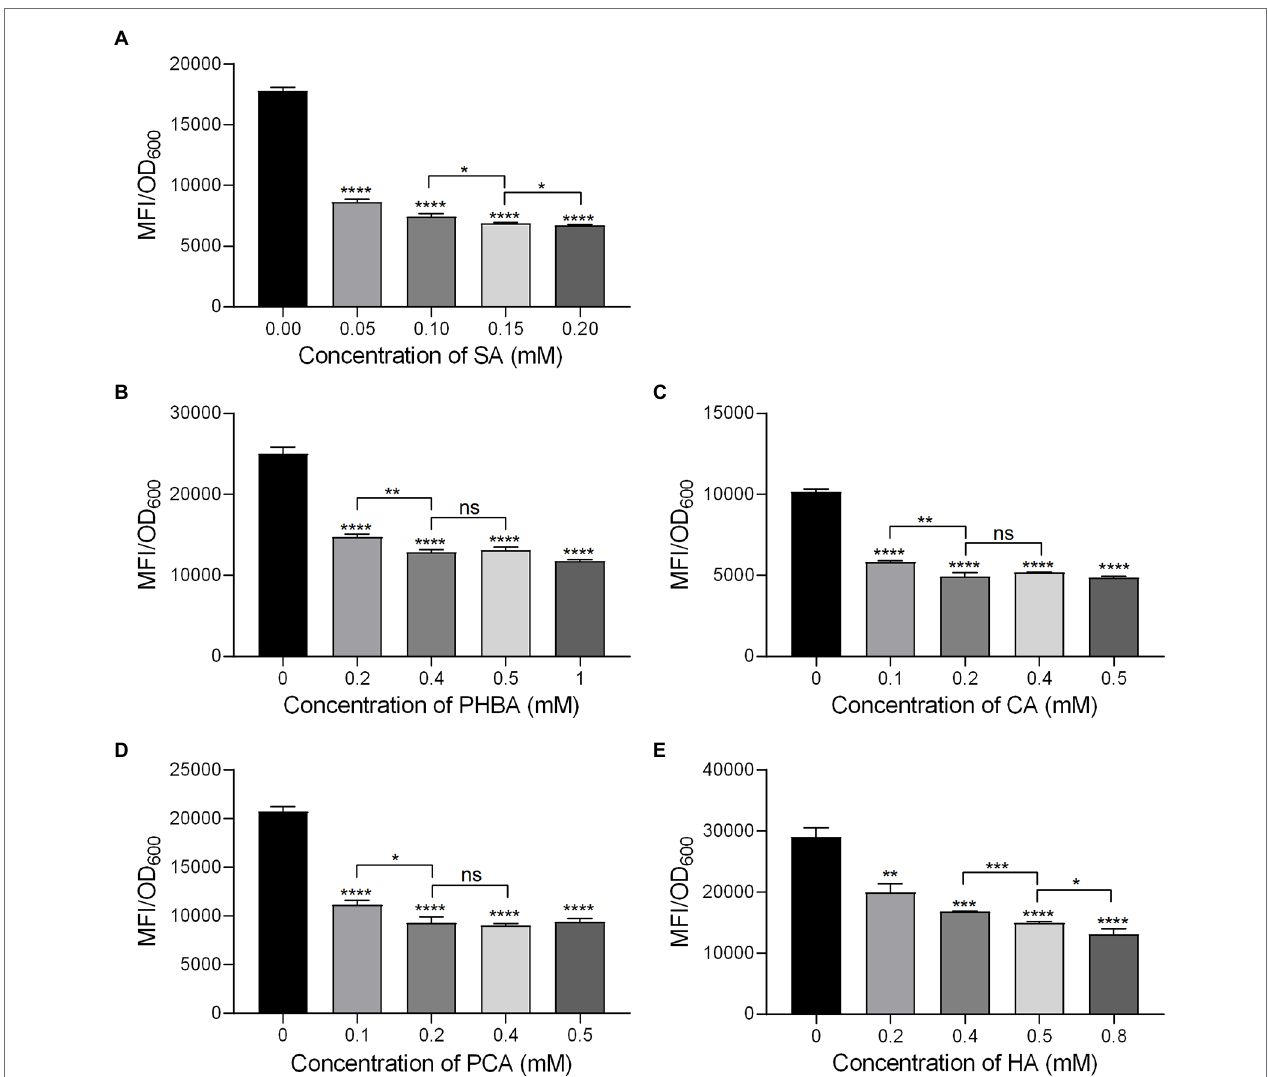
FIGURE 1 | The hrpA promoter activity of MS2 in LS5 medium supplemented with different concentrations of salicylic acid (SA; A ), p-hydroxybenzoic acid (PHBA; B ), cinnamyl alcohol (CA; C ), p-coumaric acid (PCA; D ), and hydrocinnamic acid (HA; E ) at 14 h of growth. MS2(pPhrpA-gfp) cultures (OD 600 of 2.0) were transferred into the LS5 medium supplemented with different concentrations of tested compounds or DMSO at a ratio of 1:10, and then dispended into a 96 well-tissue culture plate (100 μ l per well) for cultivation in the dark for 14 h. MFI was measured by a Multifunctional Microplate Reader. DMSO was used as the positive control. Three replicates were used in each compound and three independent experiments were performed with similar results. For statistical analysis, GraphPad Prism 8.4.3 software was used to perform Student’s t -test. Asterisks indicate statistically significant differences (* p < 0.05, ** p < 0.01, *** p < 0.001, and **** p <